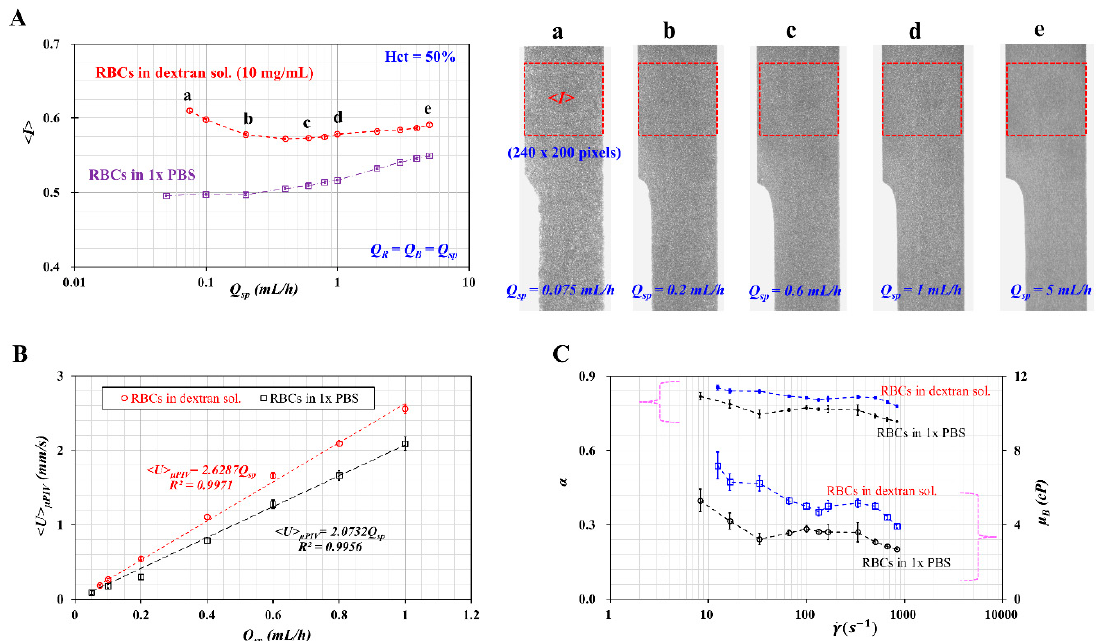
Figure 5. Quantitative evaluations of image intensity ( < I > ), blood velocity ( < U > µ PIV ), and interface ( α ) with respect to diluent. Blood samples (Hct = 50%) were prepared by adding normal RBCs into di ff erent diluents, namely 1 × PBS and dextran solution (10 mg / mL). The flow rate of each fluid was fixed at the same flow rate ( Q R = Q B = Q sp ). ( A ) Variations of microscopic image intensity ( < I > ) with respect to Q sp and diluent. The value of < I > was obtained by averaging the image intensity distributed over a specific region-of-interest (ROI) (240 × 200 pixels) selected within the test fluid channel. The right side panel shows microscopic images captured at a specific flow rate ((a) Q sp = 0.075 mL / h, (b) Q sp = 0.2 mL / h, (c) Q sp = 0.6 mL / h, (d) Q sp = 1 mL / h, and (e) Q sp = 5 mL / h). ( B ) Variations of < U > µ PIV with respect